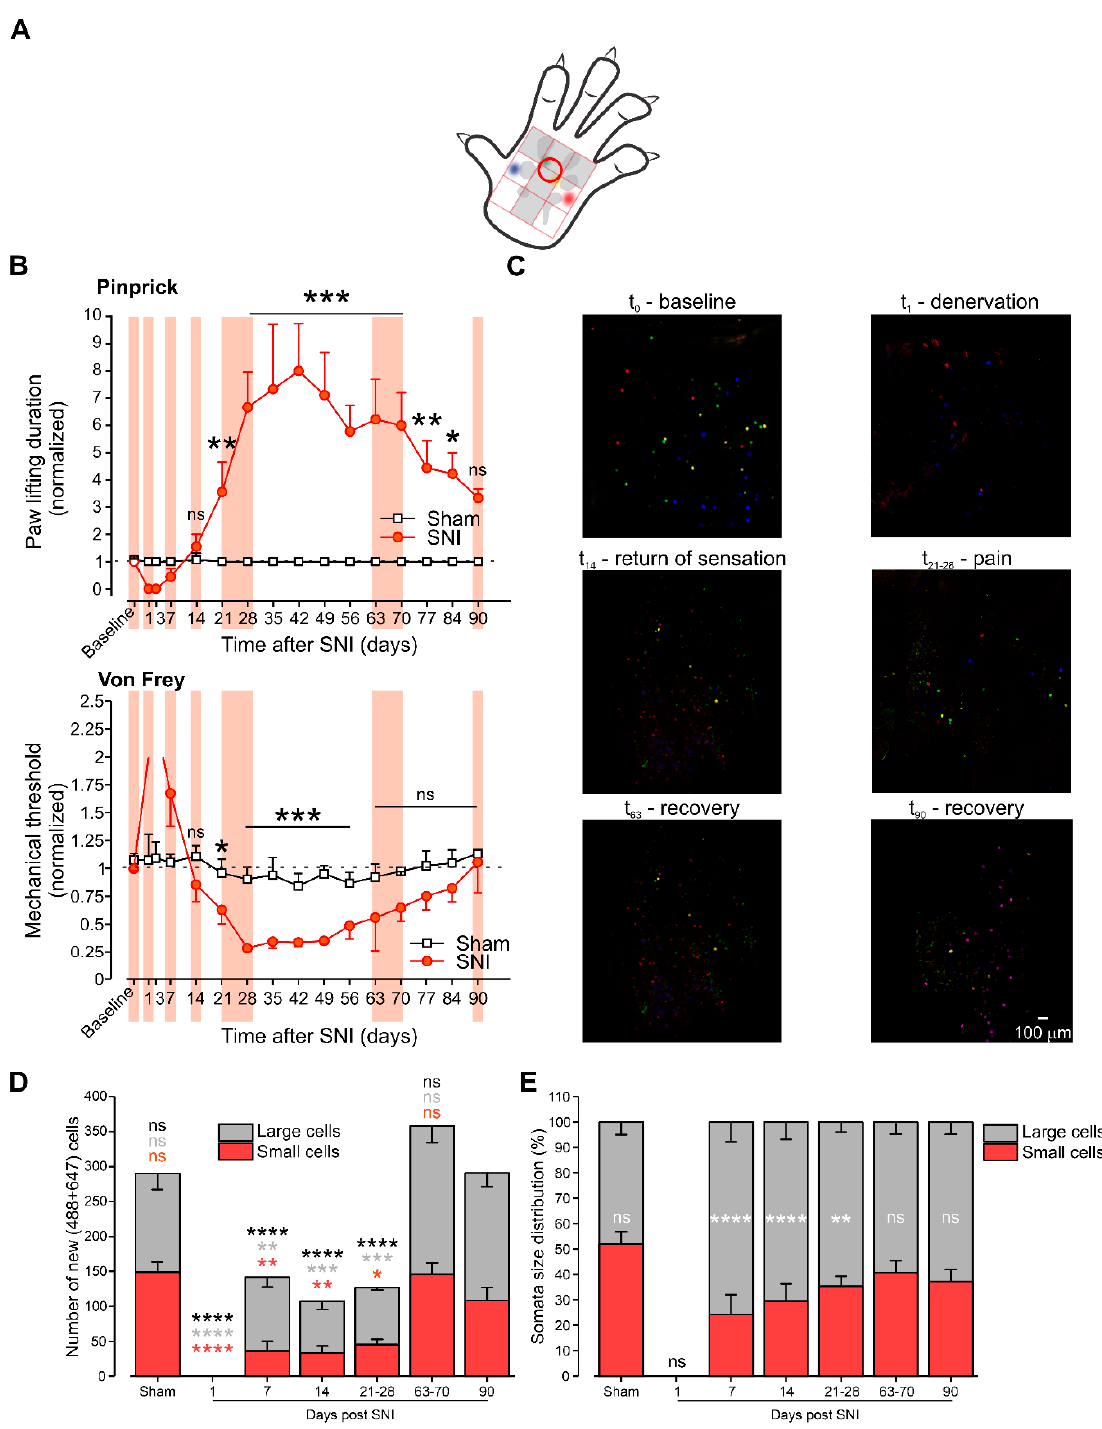
Figure 4. During the development of neuropathic pain symptoms, the skin is reinnervated by a lower number of neurons and primarily by non-nociceptive neurons. ( A ) Scheme depicting the area (red circle) to which calibrated pinprick and von Frey (VF) were applied to examine the responsiveness of the rats to noxious and innocuous mechanical stimuli, respectively. Note that the chosen area represents the part of the paw skin, which underwent denervation. ( B ) Changes of the response to pinprick (upper panel) and VF (lower panel) at the indicated times following sham surgery (white squares) and SNI surgery (red circles). The baseline value represents the mean value of the 3 tests performed at three consecutive days before SNI or sham surgery. All of the values were normalized to the baseline value. *** p < 0.001; ** p < 0.01; * p < 0.05; ns—not significant, n = 6 rats in each group, RM two-way ANOVA). Pink vertical areas outline the times at which some of the animals were pulled